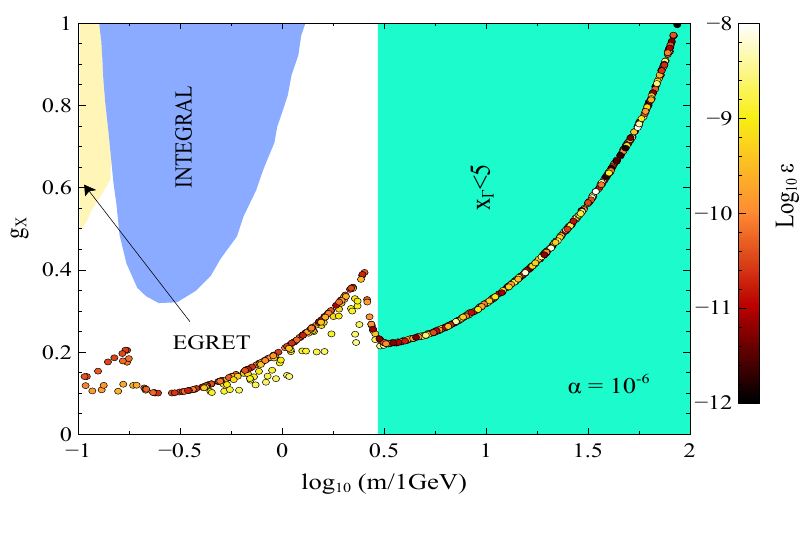
Figure 9 . Allowed values of g X while varying m between 0.1 GeV to 100 GeV for a fixed value of scalar mixing angle α . The colour bar indicates the corresponding allowed range of (cid:15) . The light yellow and the light blue regions are disallowed from indirect detection constraints coming from diffuse γ ray background. A detailed discussion on indirect detection is given in section